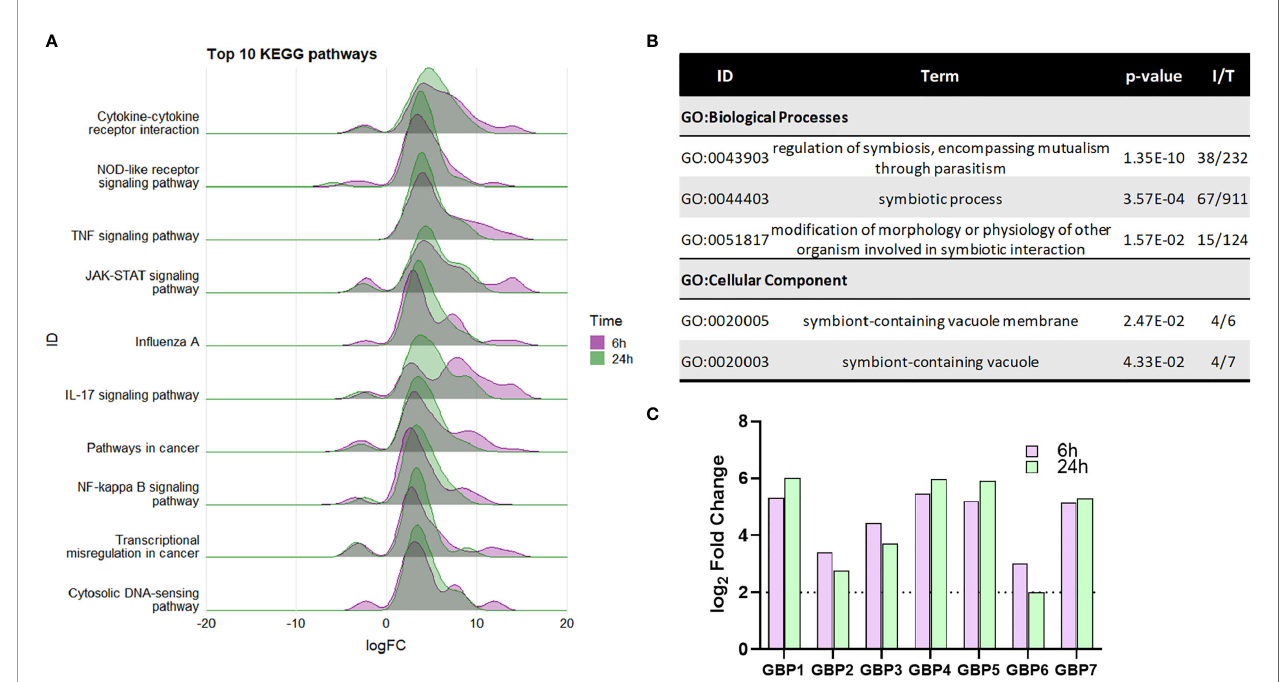
FIGURE 4 | Enrichment of macrophage intracellular immune responses during NTHi persistence. (A) KEGG pathway analysis identi fi ed a number of enriched immune processes, with a number of pathways indicating a response to an intracellular pathogen. The genes assigned to each process were more highly upregulated at both 6 h (purple) and 24 h (green). Pathway/category IDs are ordered by enrichment signi fi cance (FDR). (B) Signi fi cantly enriched GO terms in the Biological Process and Cellular Component categories relating to host-pathogen symbiosis for the 863 core genes differentially expressed at 6 h and 24 h (log 2 FC ± 2, FDR p < 0.05). P-value indicates the enrichment FDR, I = input number of genes, T= total number of genes in annotation. (C) MDM upregulation of guanylate- binding proteins (GBPs) 1-7 involved in host response to intracellular pathogens. Purple bar = 6 h, green bar = 24 h. Dotted line indicates log 2 FC2 cut off. All genes were statistically signi fi cantly upregulated at both time points (FDR p <